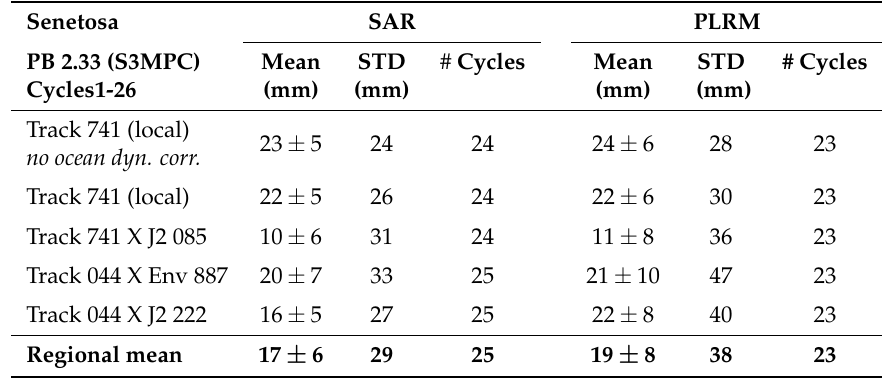
Table 4. Statistics on the Sentinel-3A SAR and PLRM SSH absolute regional SSH bias estimates off